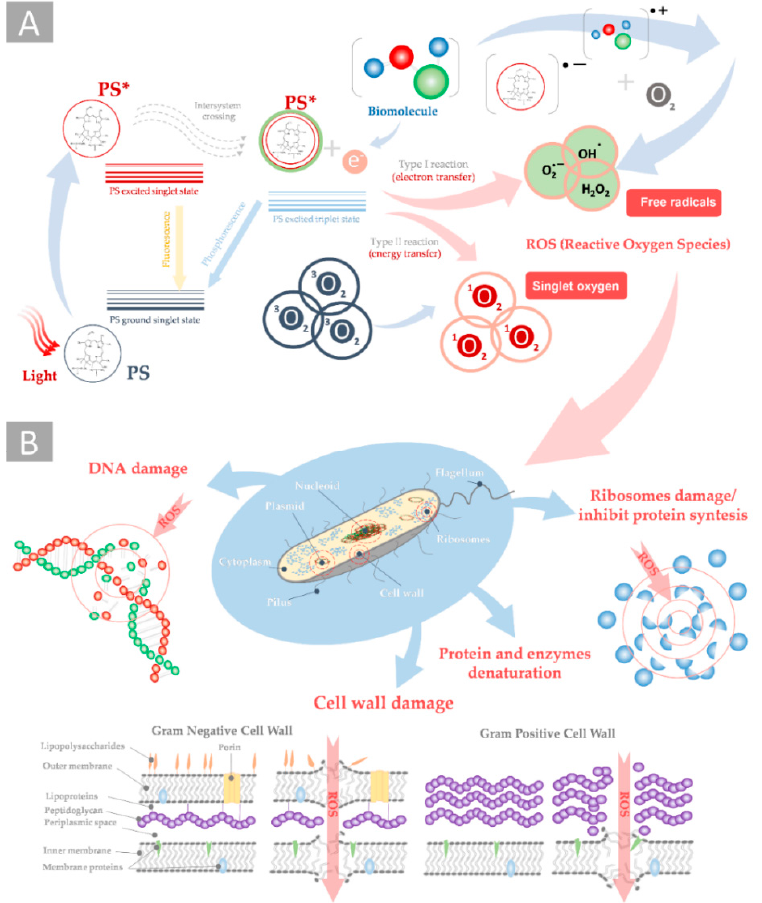
Figure 1. Schema of antimicrobial photodynamic therapy: ( A ) photoexcitation and generation of ROS by type I and II photodynamic reactions and ( B ) the mechanism of the ROS-induced destruction of bacteria cell structures leading to bacteria cell death (*-indicates the photoexcitation).